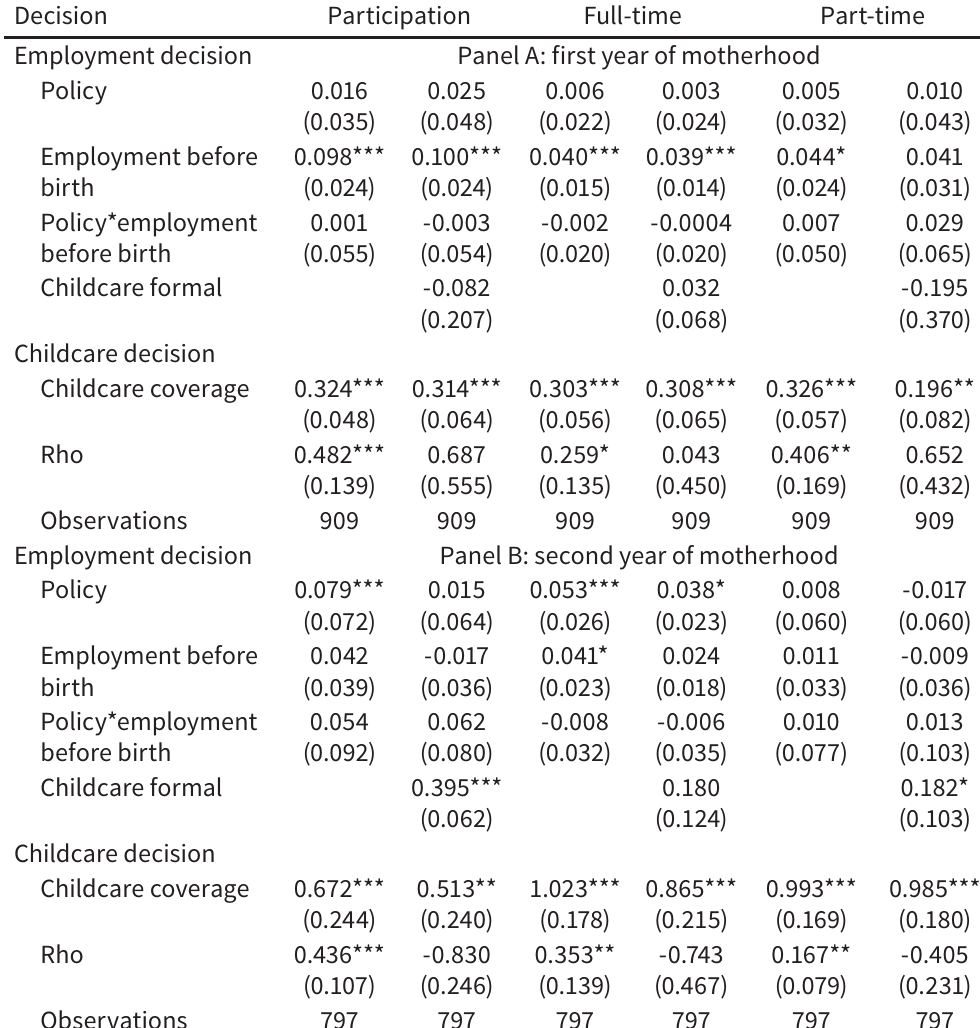
Table 7 Average marginal effects for maternal childcare decision: low-income category Decision Participation Full-time Part-time Employment decision Panel A: first year of